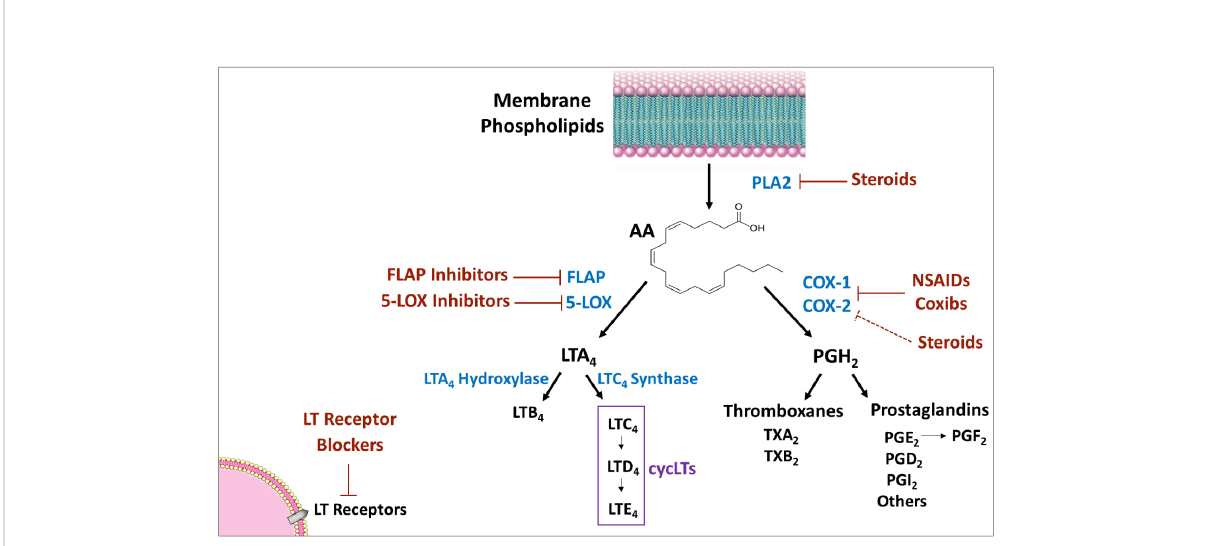
FIGURE 1 Eicosanoids synthesis cascade. PLA2 produces AA from membrane phospholipids. Thereafter, there are two main pathways for AA metabolism: 1) COX pathway - the enzymes COX-1 and 2 convert AA to PGH2 which is converted by different isozymes to various prostaglandins and thromboxanes; and, 2) 5-LOX pathway - the enzyme 5-LOX (together with the enzyme FLAP) converts AA to LTA4, which is then converted to various leukotrienes. Medications that in fl uence the synthesis/activity of mediators/enzymes are marked in red. Arrow indicates "production/ induction"; solid line indicates inhibition/locking; dashed line indicates indirect inhibition. AA, arachidonic acid; COX, cyclooxygenase; FLAP, fi ve lipoxygenase activating protein; LOX, lipoxygenase; LT, leukotriene; NSAIDs, non-steroidal anti-in fl ammatory drugs; PG, prostaglandin; PL, phospholipase; TX,